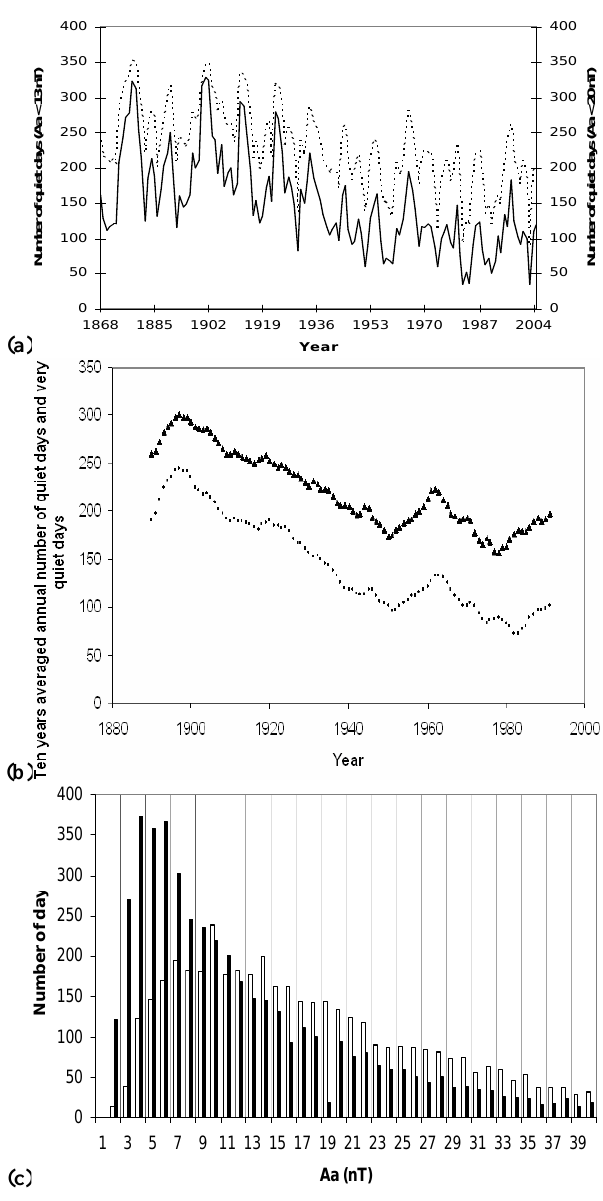
Fig. 3. (a) Annual number of quiet days (Aa < 20nT; dashed line) and very quiet days (Aa < 13nT; full line) from 1868 until now; (b) 10-year running average of the number of quiet days (triangles line) and very quiet days (dotted line) with a sliding step of one year; (c) histograms of the Aa values (0 < Aa < 40nT) during solar cycles 12 (black bars) and 20 (white bars).